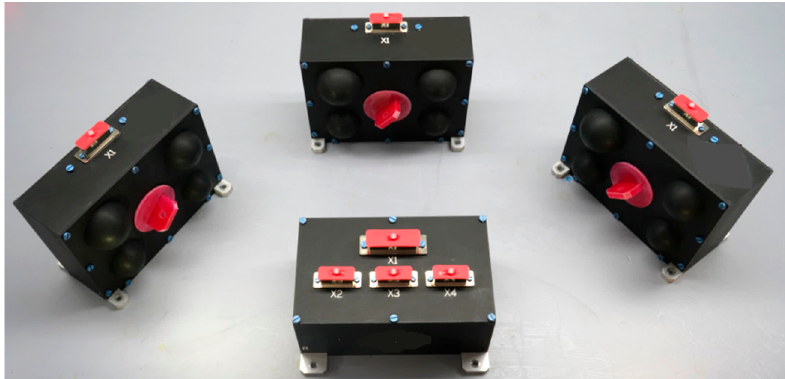
Figure 5. The photograph of the radiation dose detector.